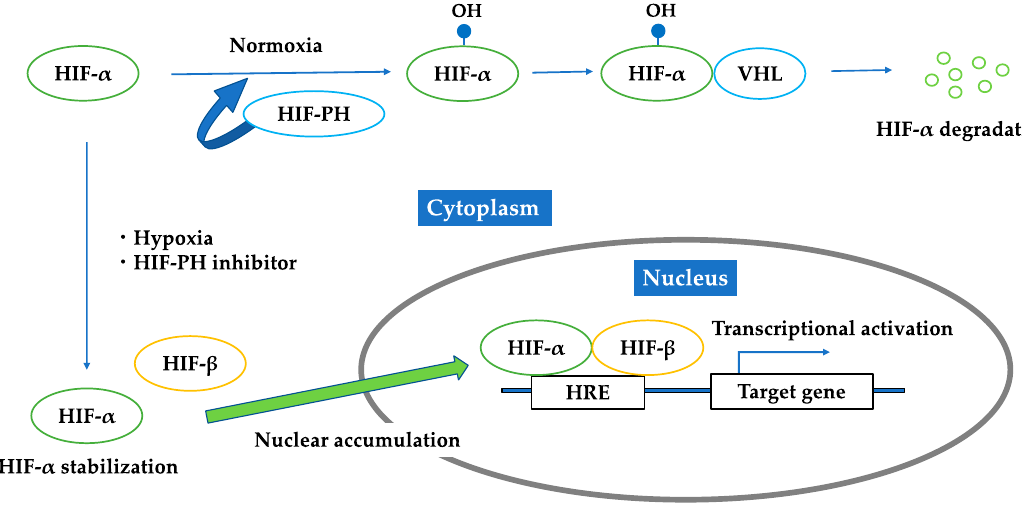
Figure 3. Regulation of HIF under normoxic condition; hypoxic condition; HIF-PH inhibitor. Under normoxic conditions, HIF- α is hydroxylated by HIF-PH and then recognized by von Hippel–Lindau tumor suppressor protein to be degraded. Under hypoxia or the existence of HIF-PH inhibitor, HIF- α is not hydroxylated, but is stabilized in cytoplasm and forms a heterodimer with HIF- β . This heterodimer translocates into the nucleus, binds to the hypoxia responsive elements, and activates downstream genes.